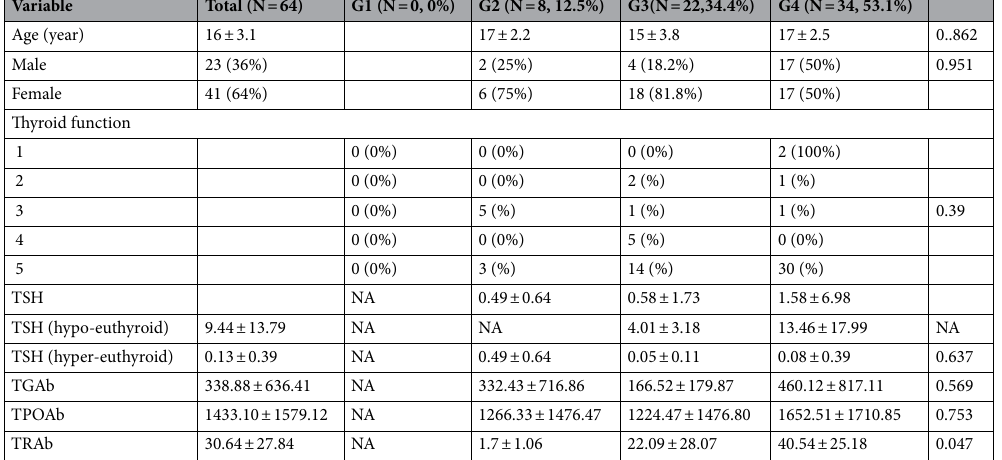
Table 3. Clinical characteristics according to ultrasound grade in GD patients. G, grade; N, number of patients; TSH, thyroid stimulating hormone; TG, antithyroglobulin antibodies; TPO, antithyroid peroxidase antibodies; TRAb, TSH receptor antibodies; NA, not assessable.